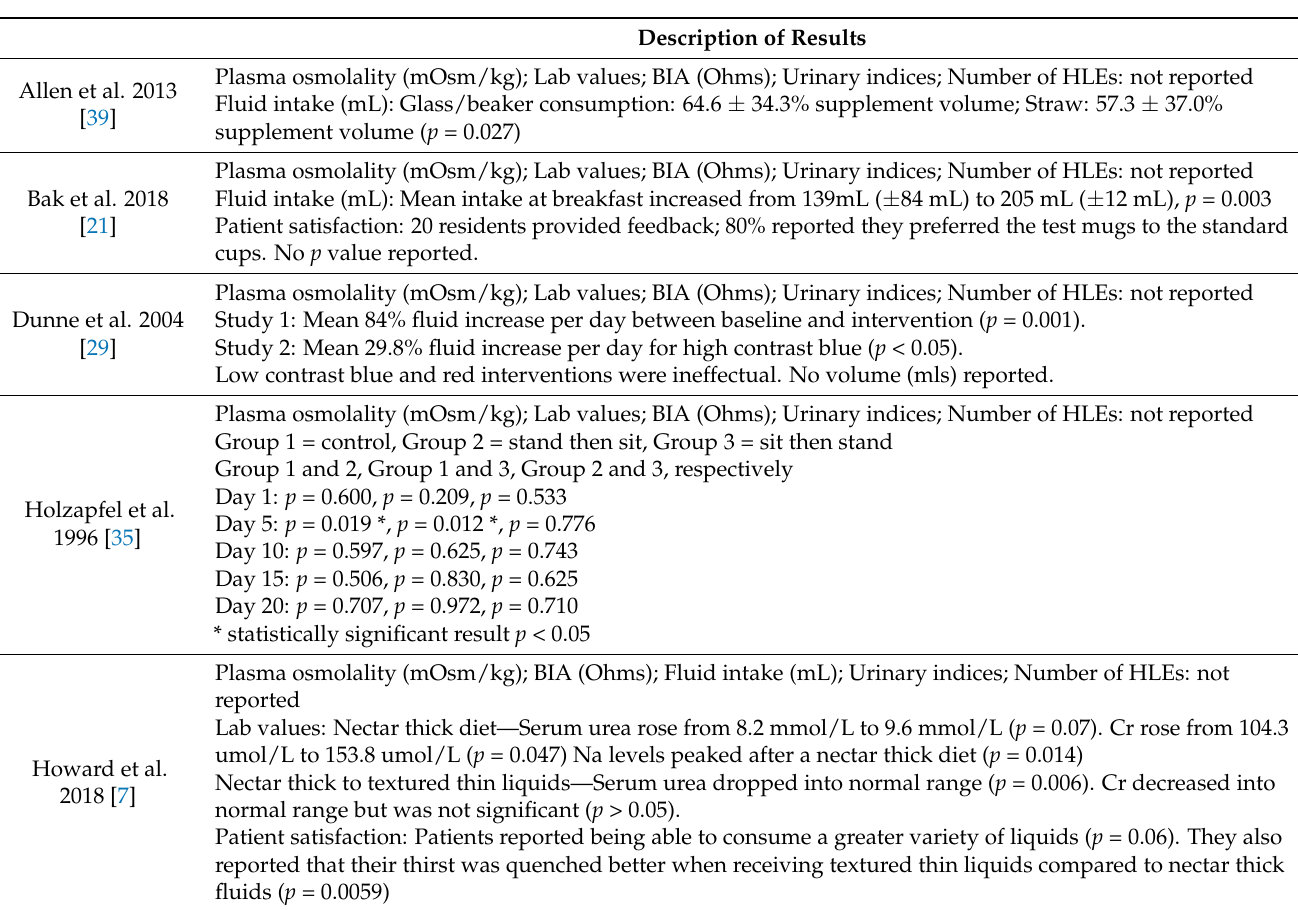
Table 3. Results of included studies ( n =